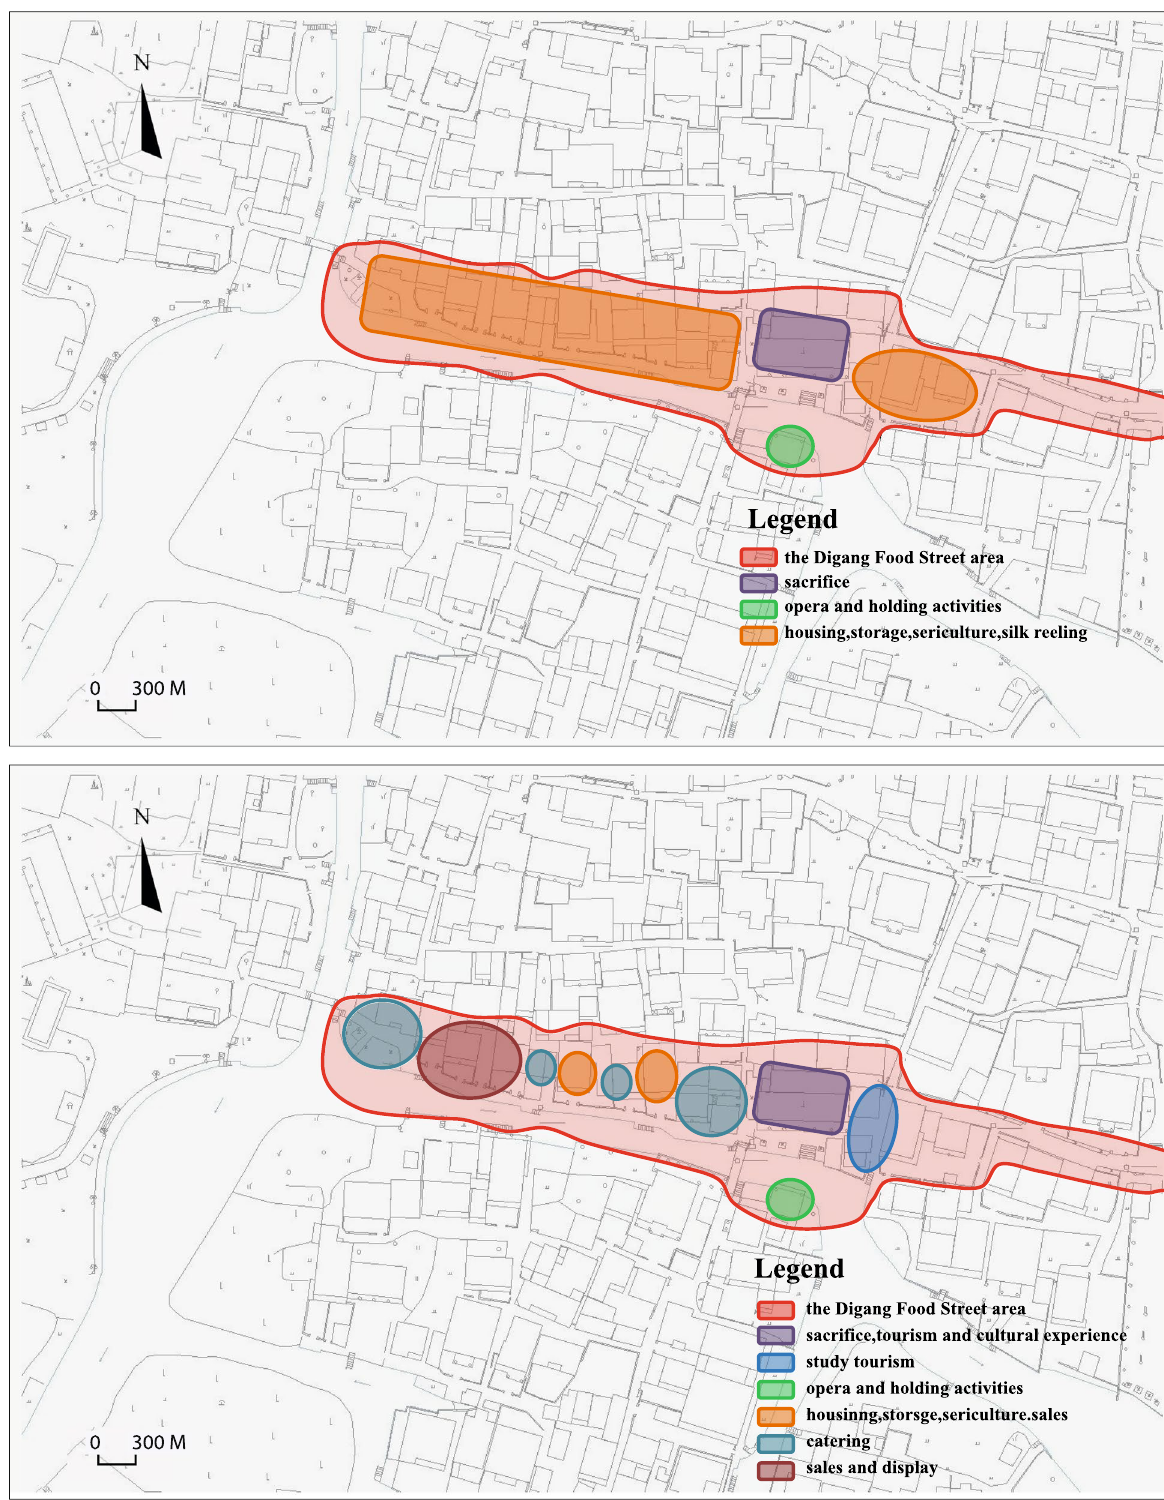
Fig. 7 Functional changes to Digang Food Street. a: The original function of Digang Food Street b: Post adaptive functions of Digang Food Street (Source: the